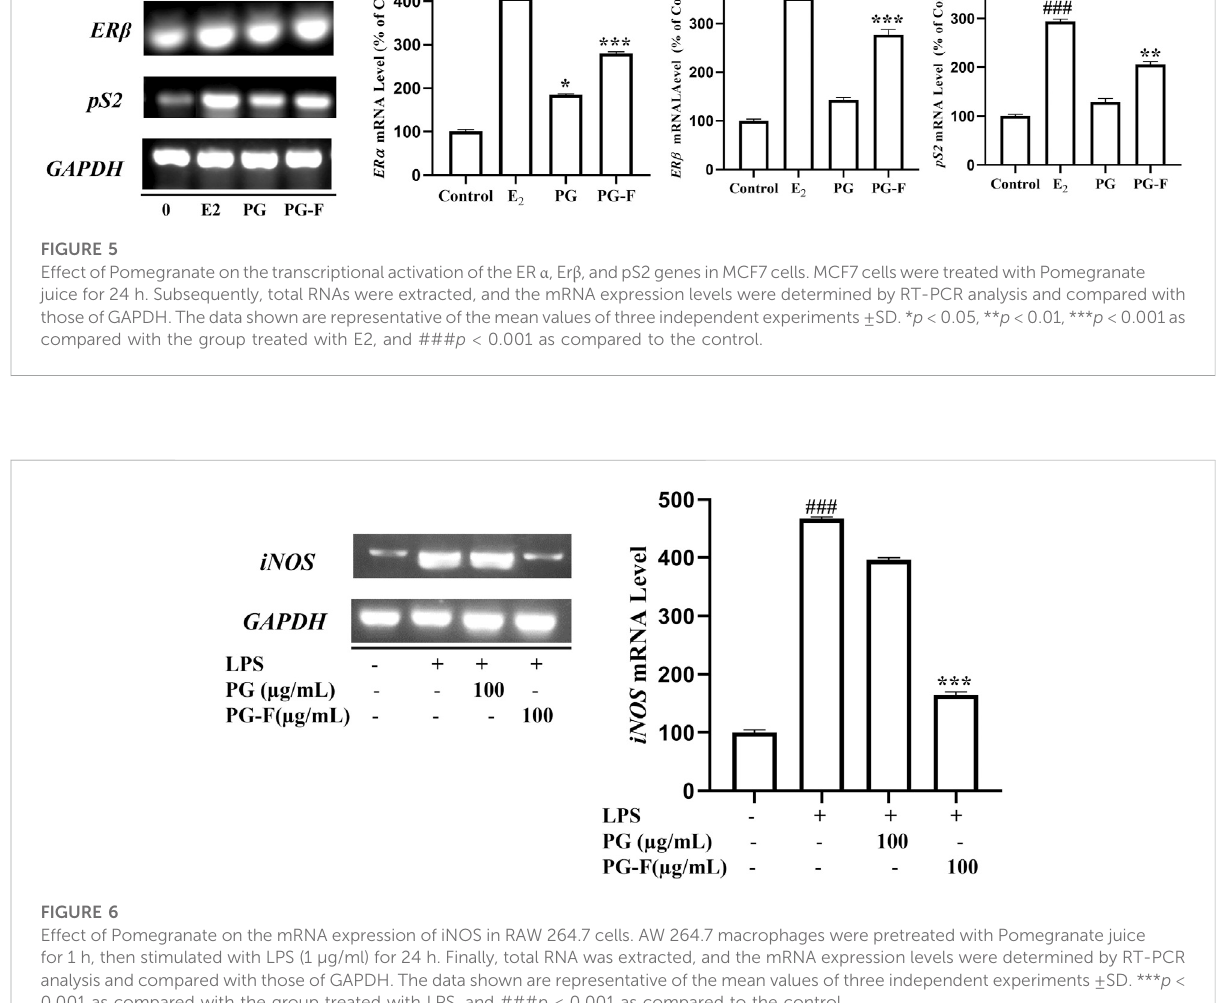
Figure 3, NO production is signi fi cantly higher in LPS-treated cells, whereas in Pomegranate treated LPS-induced cells, NO production has decreased in a dose-dependent manner (Figure 4).